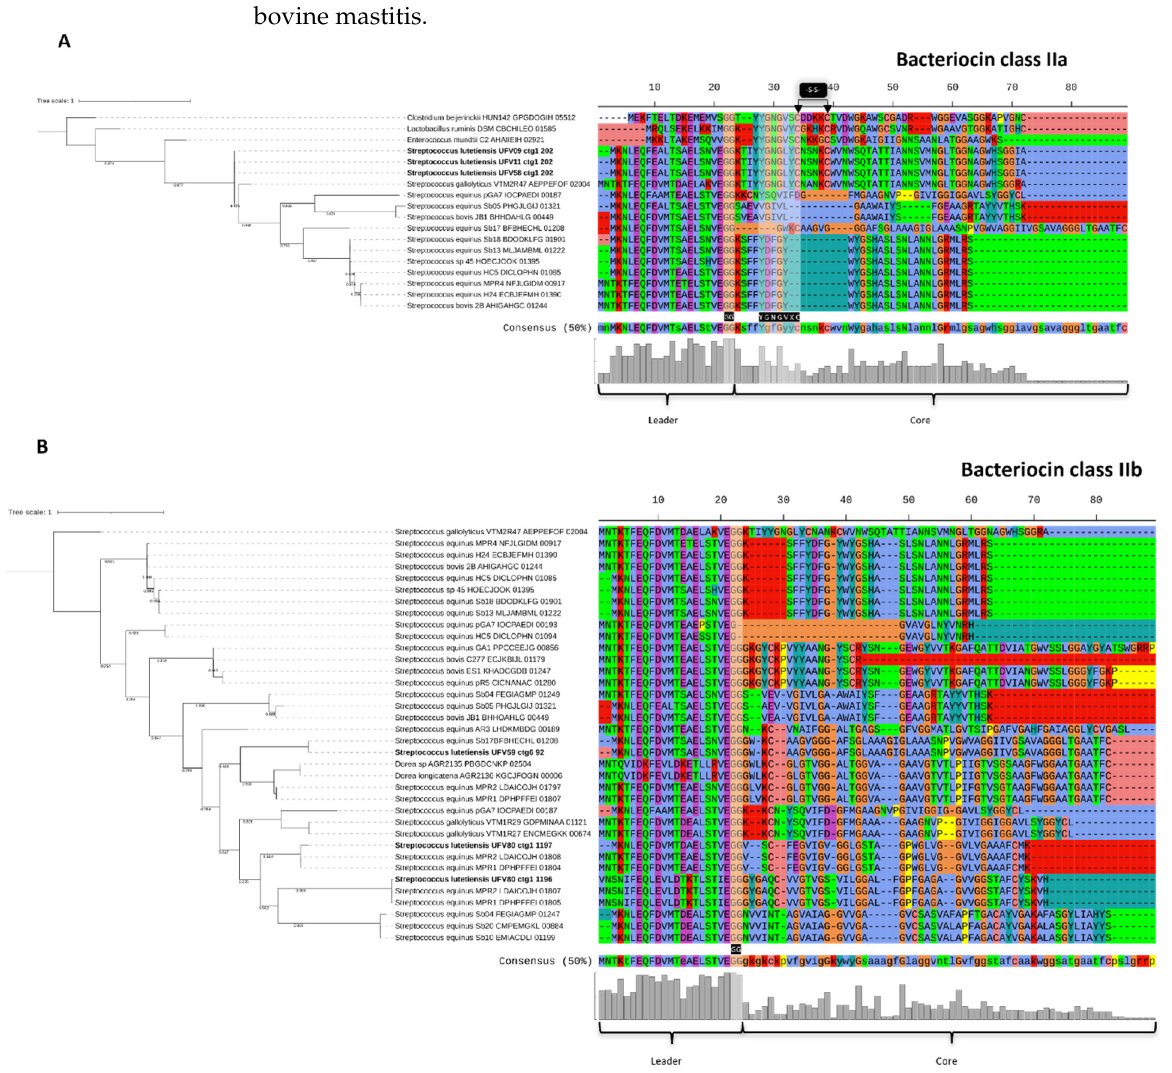
Figure 7. Phylogenetic tree and alignment of precursor peptides predicted in the genomes of S. lutetienses strains with the genomes of ruminal bacteria from the Hungate1000 project. Phylogenetic tree of the bacteriocin class IIa ( A ) and class IIb ( B ). Sequences were aligned using Muscle v3.8.31 and the phylogenetic trees were constructed using FastTree v2.1 (Maximum Likelihood method, 1000 replicates). Trees were visualized and annotated in the Interactive Tree Of Life v5 (iTOL). The bootstrap values are shown near resolved branches. The scale bar represents 0.01 nucleotide substitutions per nucleotide position. The leader and core regions of the precursor peptides are indicated below the conservation annotation sequence by the black brackets. S. lutentienses strains characterized in this study are shown in bold. Conserved amino acid residues related to the bacteriocin are highlighted by hatched area and black arrows.